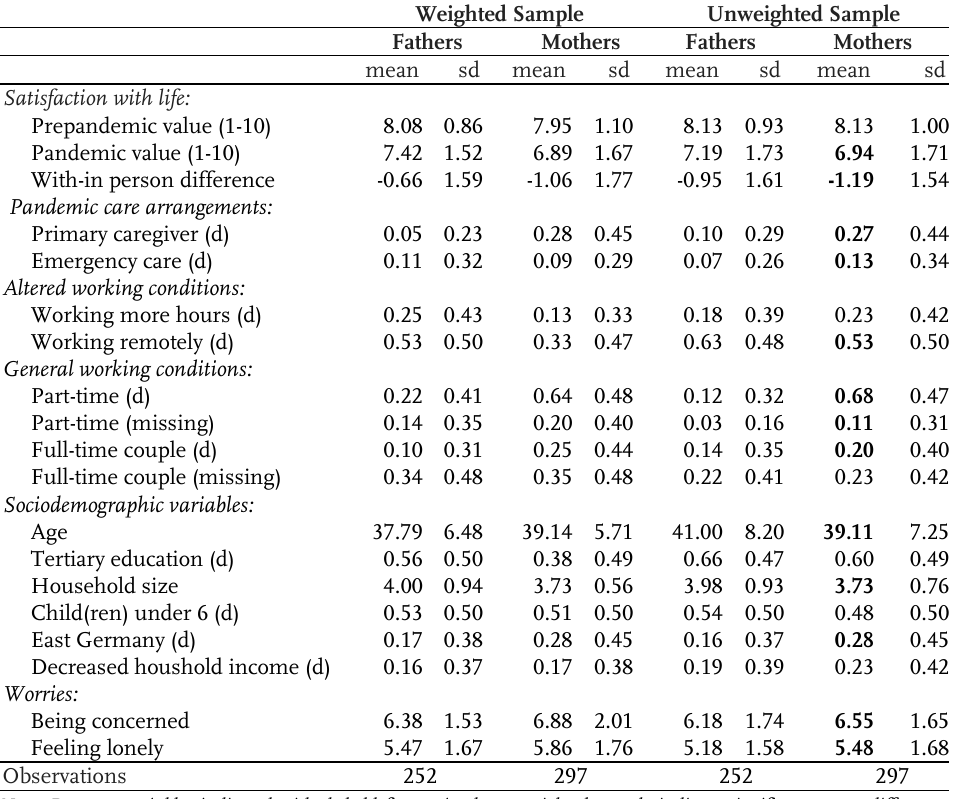
Table 1: Description of dependent and independent variables (weighted and unweighted